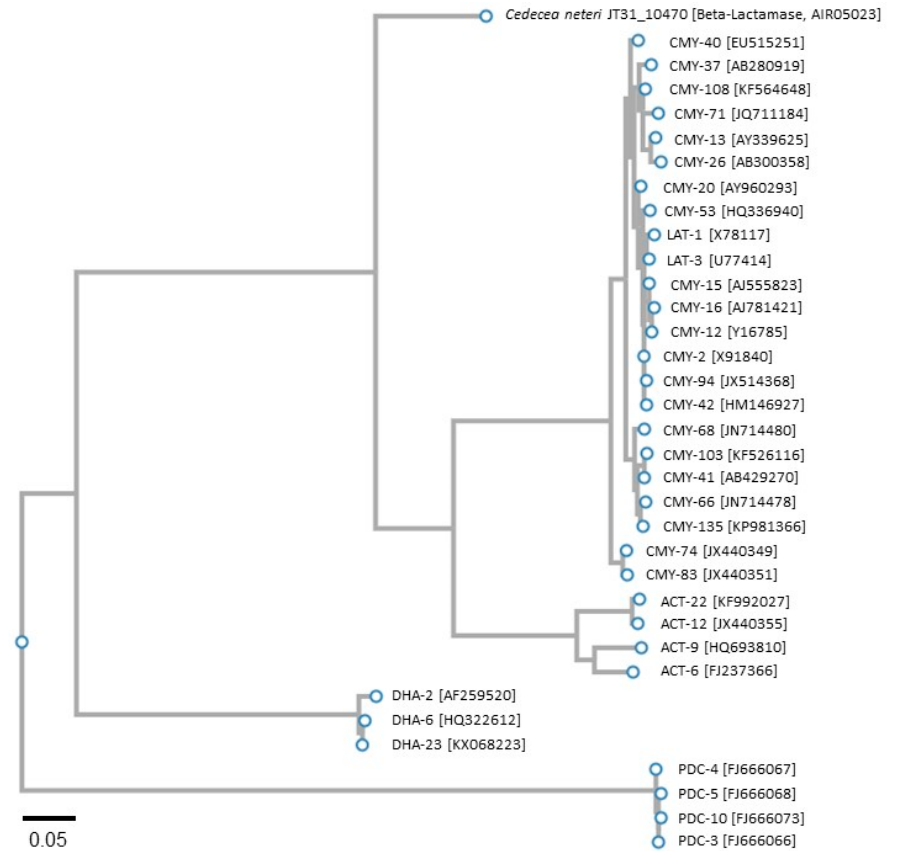
Figure 1. Evolutionary relationships between C. neteri JT31_10470 (predicted β -lactamase) and AmpC family variants estimated using the ETE3 phylogenetic analysis pipeline to construct a FastTree v2.1.8 phylogram from top-scoring amino acid alignments. GenBank accession numbers for each protein are provided in brackets.